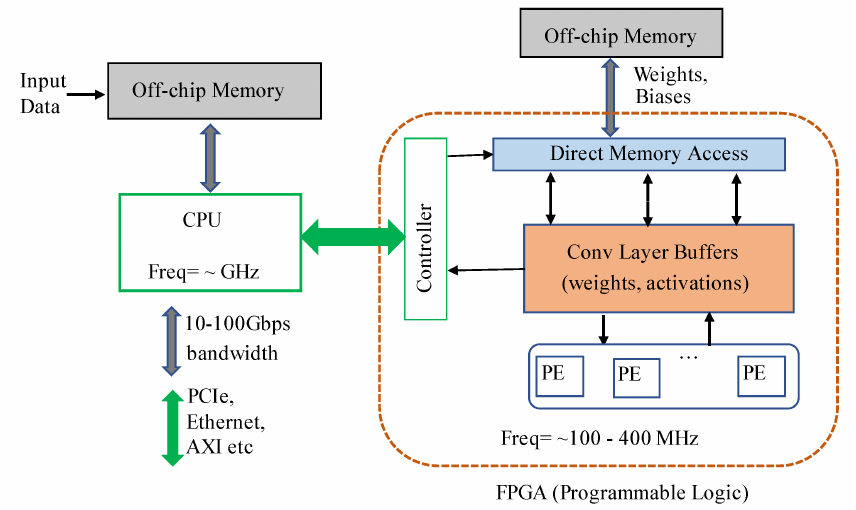
Figure 1. Traditional architecture of hybrid FPGA-CPU based inference solutions